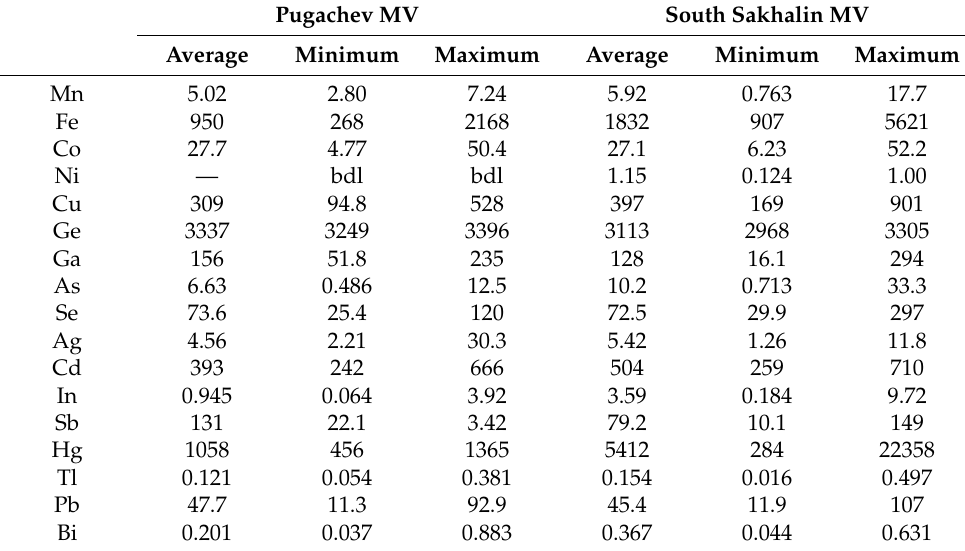
Table 8. Average trace-element compositions of low- and medium-Hg sphalerite with heterogenous Hg distribution from mud masses of Pugachev (n = 6) and South Sakhalin (n = 12) MVs, Sakhalin Island. LA-ICP-MS data, ppm.